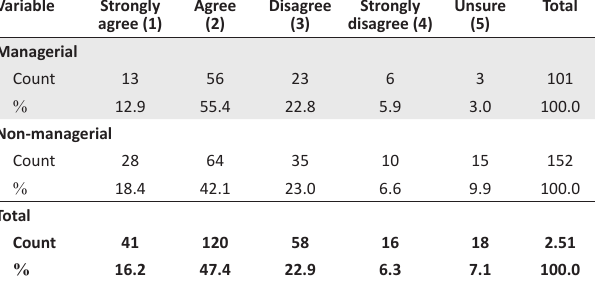
TABLE 5: Participants’ response to the view that state-owned enterprises encourage creativity. Variable